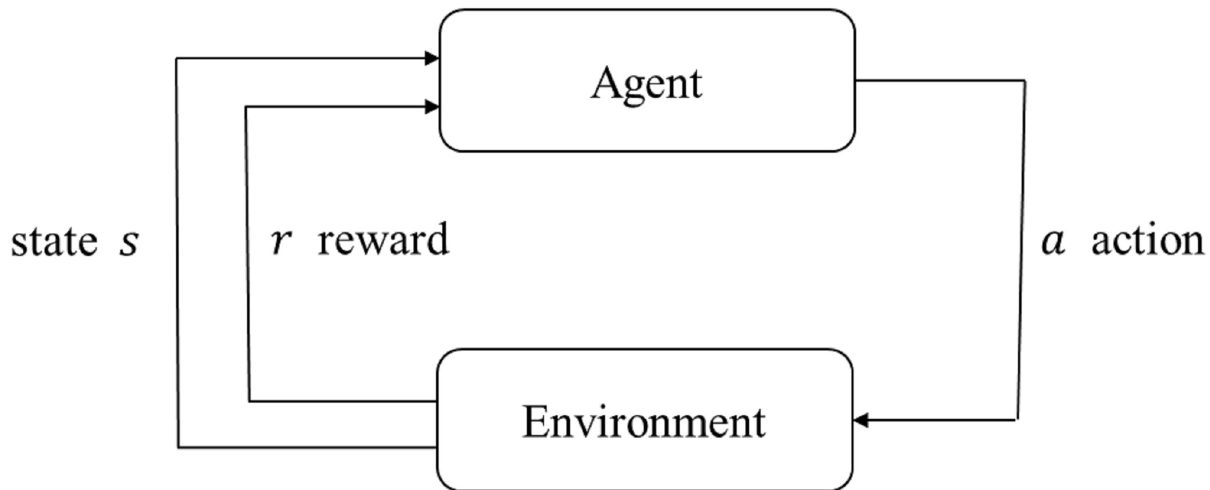
Fig 2. Basic reinforcement learning model. When the Agent performs an action, the state of the environment is changed, and a reward signal is feedback to the Agent. The Agent selects the next action according to the reward signal and the current state of the environment, and the selection principle is to increase the probability of receiving positive reinforcement (maximizing rewards). The actions selected affect not only the immediate rewards, but also the state of the environment at one point and the final values.